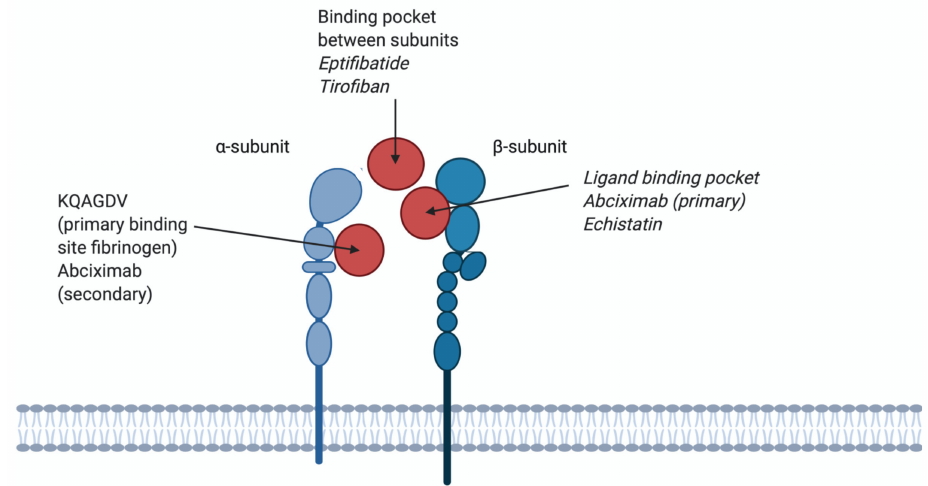
Figure 4. Different binding sites of antagonists on α IIb β 3 integrins. KQAGDV; the primary binding site for fibrinogen and a secondary binding site for abciximab. The binding pocket between subunits; binding site for eptifibatide and tirofiban, therefore competing with fibrinogen. Binding pocket β 3; primary binding site for abciximab and echistatin, therefore not competing with fibrinogen.